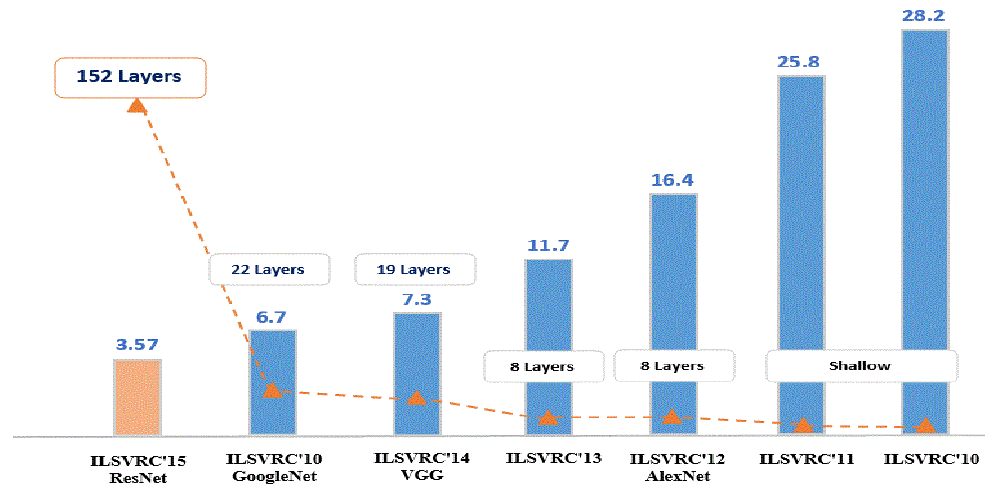
Figure 21. Types of CNN explained.